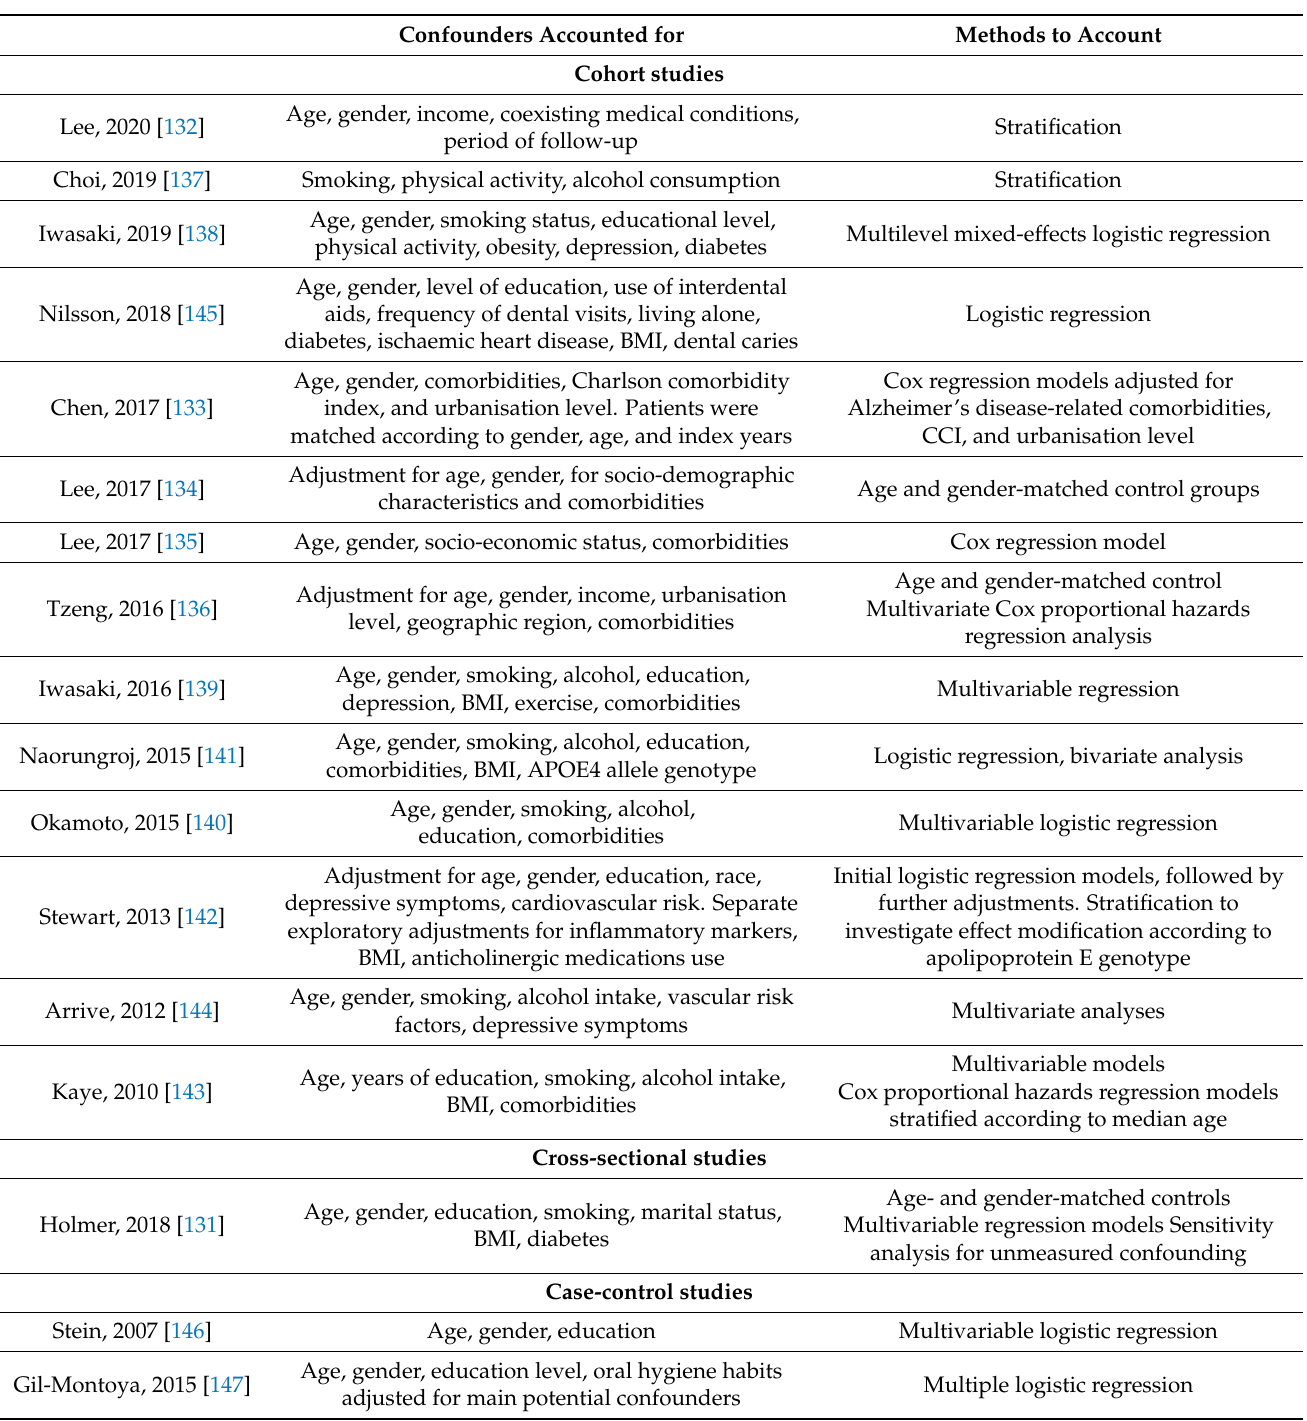
Table 7. Methods used to account for confounders in 17 included